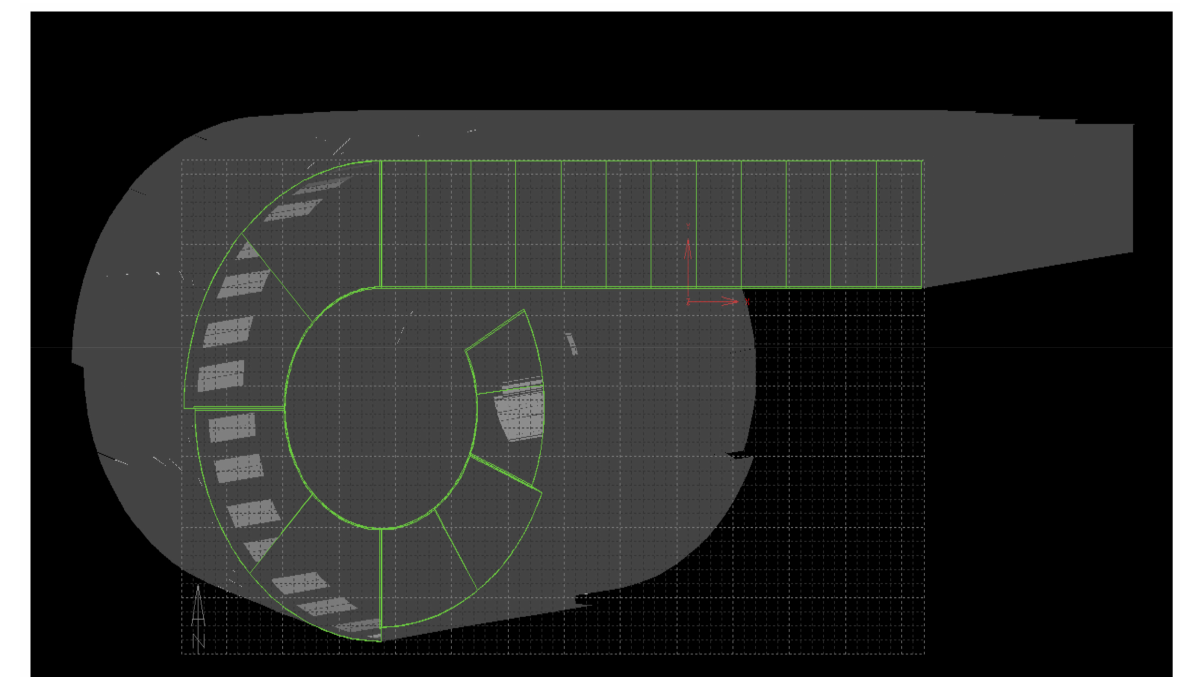
Figure 13. Animated annual shadow changes of the building.